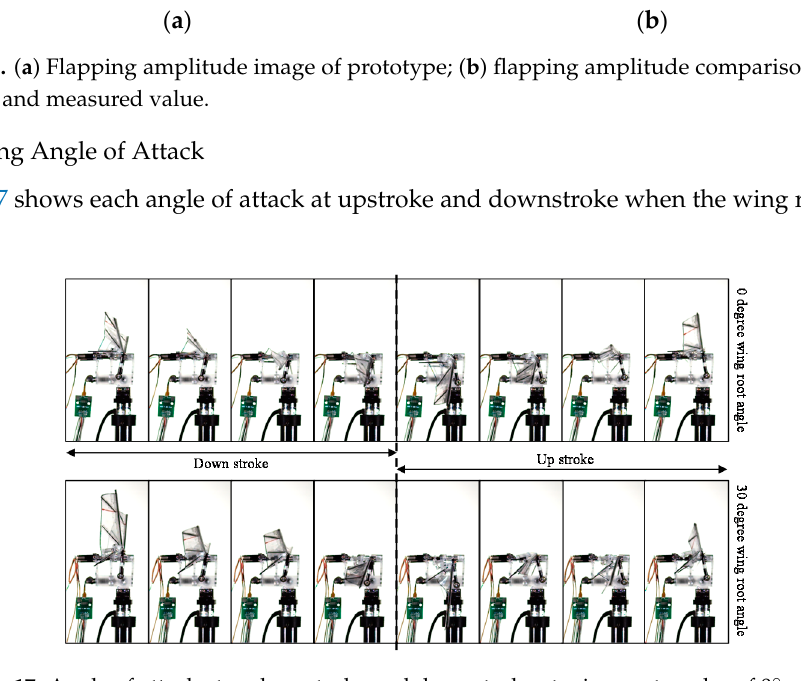
Figure 17. Angle of attack at each upstroke and downstroke at wing root angles of 0° and 30°.